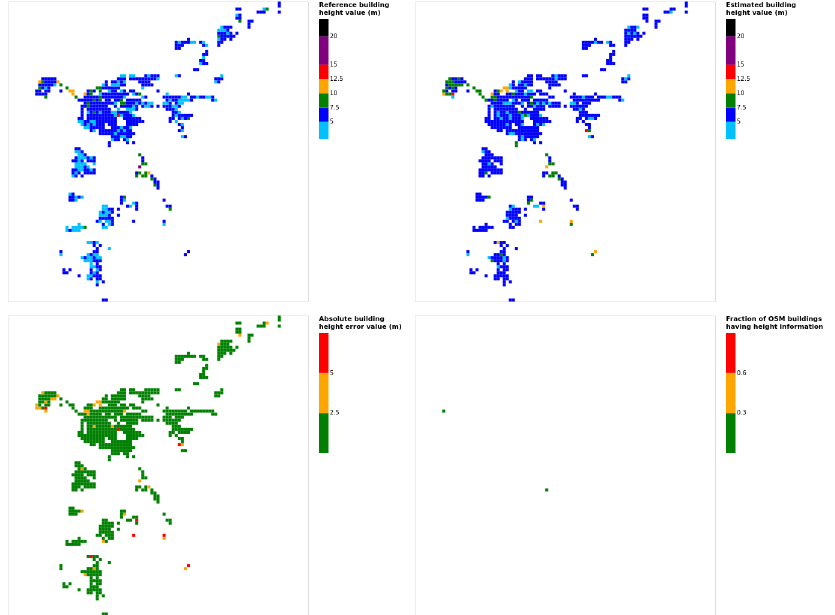
Figure B21. Results for the commune at grid cell (upper left panel) reference building height, (upper right panel) estimated building height, (lower left panel) absolute building height error, and (lower right panel) fraction of OSM buildings that have height information. For all panels except the lower right, only cells that have buildings – with at least 90% of their buildings having no height value in OSM – are displayed.